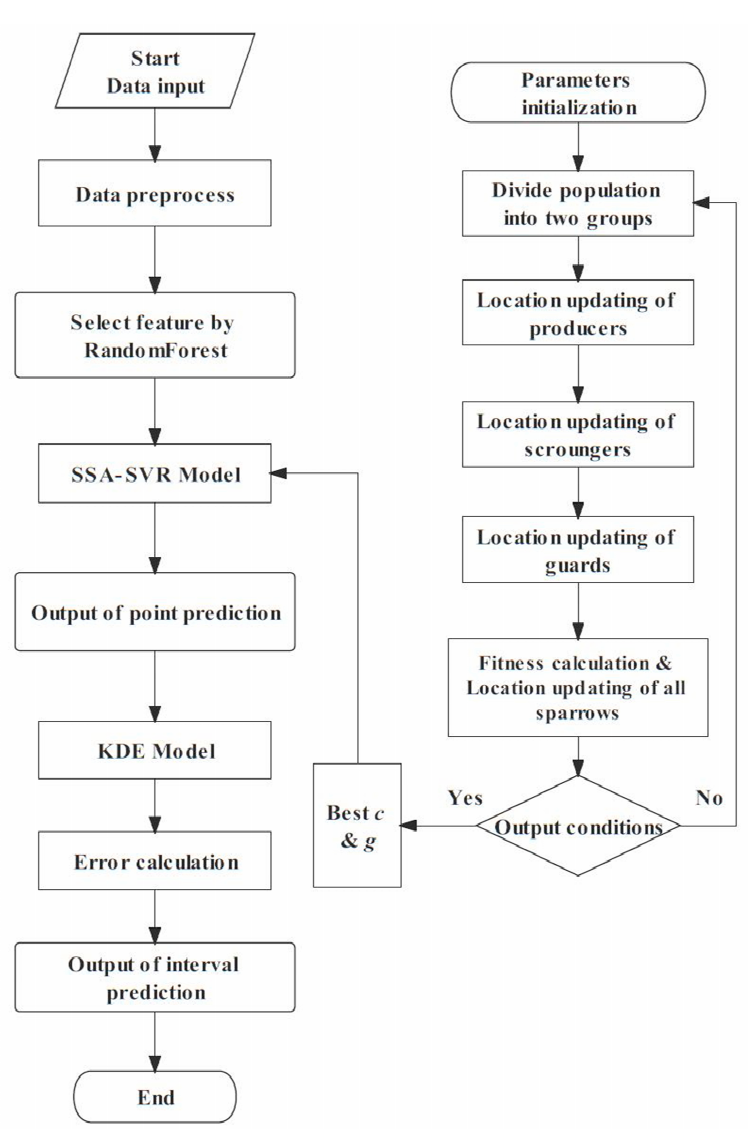
Figure 1. RF-SSA-SVR-KDE